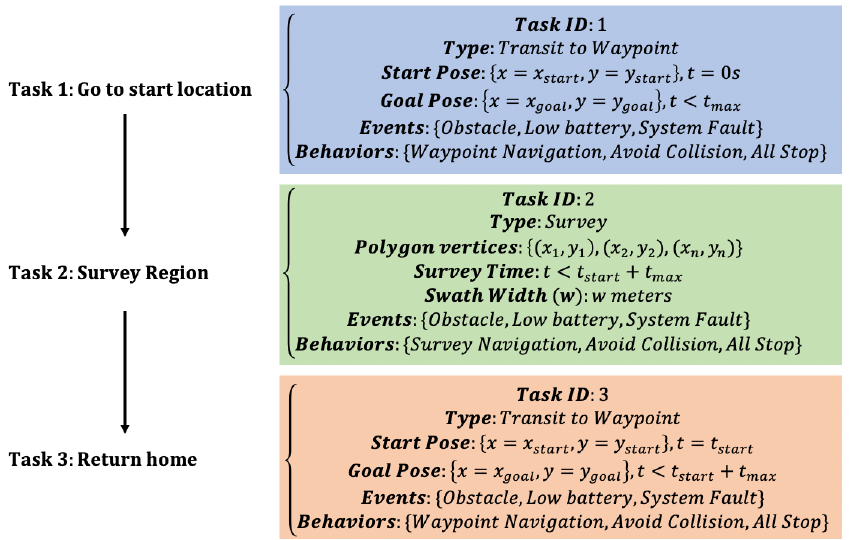
Figure 1. Example seafloor mapping mission with associated tasks and